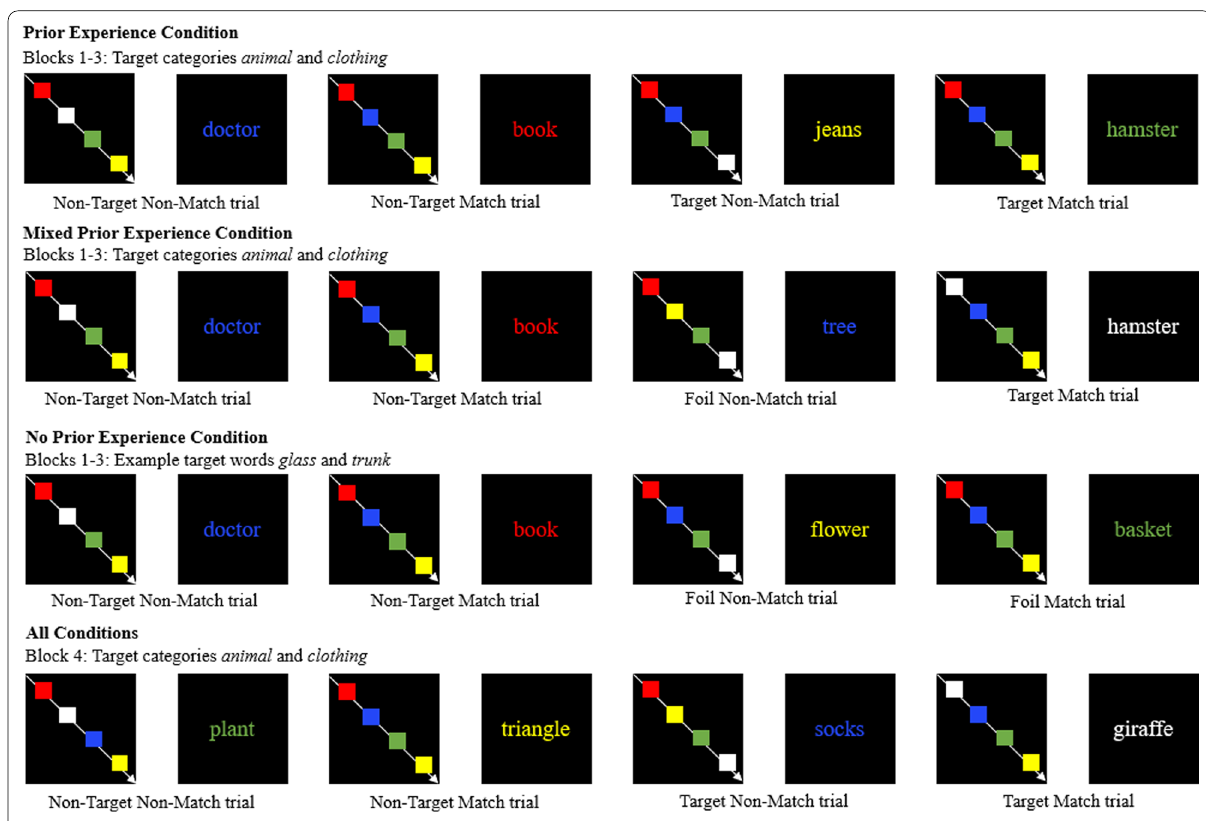
Fig. 3 Example of trial types by block and condition in Experiment 2. Note: The colored rectangles each appeared by themselves on a screen followed by an interstimulus interval. They are presented all together here due to space constraints. The following comprises an example and may not correspond to words actually used on the